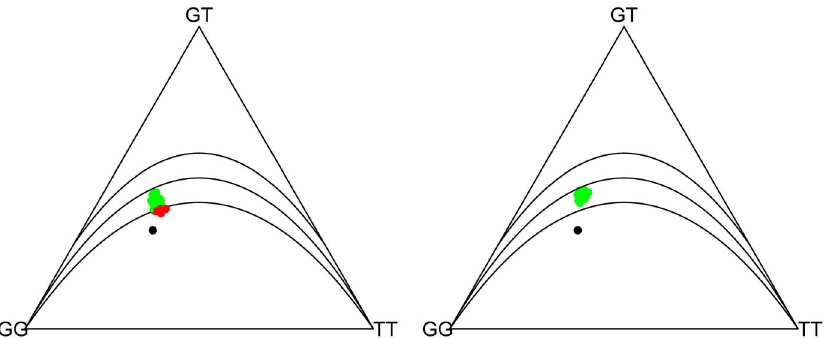
Figure 3. Ternary plots of m =50 imputed data set for the G/T polymorphism of Figure 1. Curves in the ternary plots indicate the HW parabola, and the limits of the 95% acceptance region of a x 2 test for HWP. Left panel: imputed data sets with allele intensities as covariates (model 3). Right panel: imputed data sets with allele intensities and 1 covariate SNP (model 5).